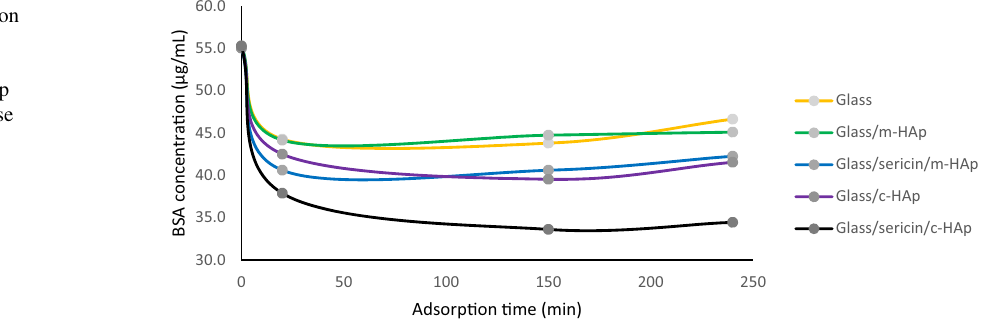
Fig. 12 The BSA adsorption on glass (blank), glass/c-HAp, glass/m-HAp, glass/sericin/c- HAp, and glass/sericin/m-HAp substrates, reported as decrease in BSA concentration versus contact time.